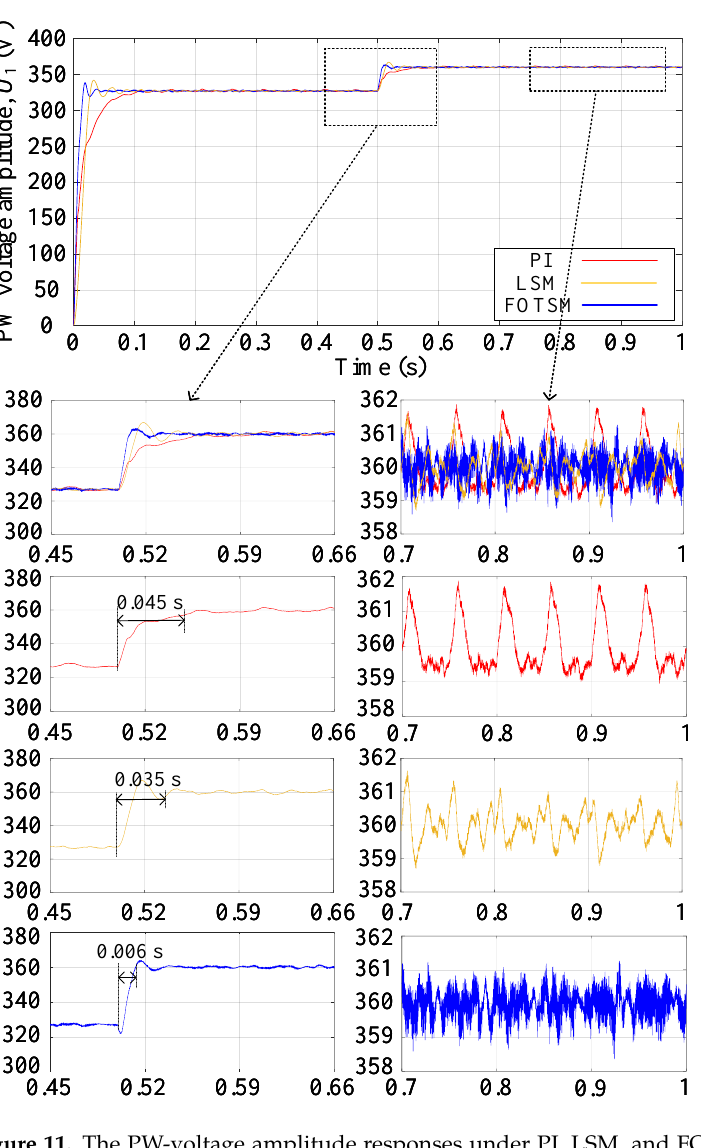
Figure 11. The PW-voltage amplitude responses under PI, LSM, and FOTSM during the voltage change process.